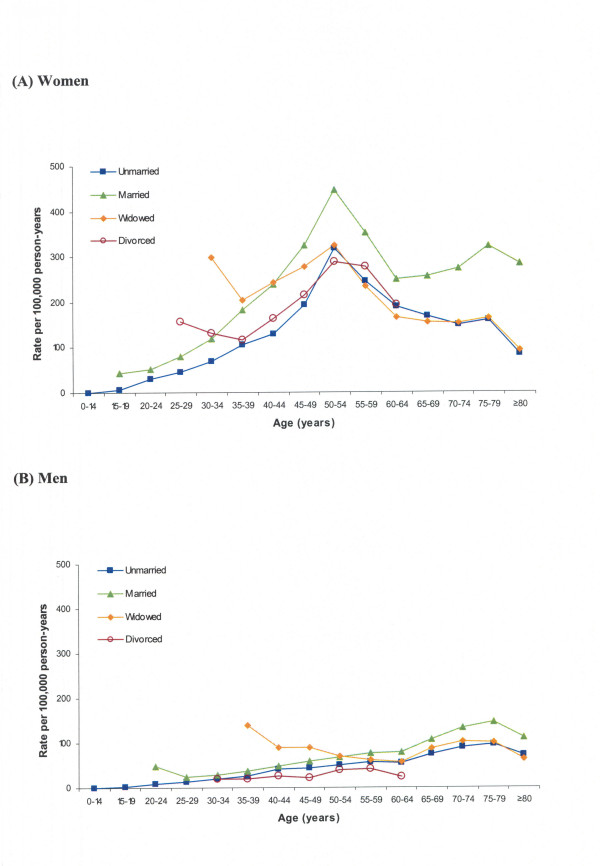
Age-specific rates of in-hospital cases of CTS according to marital status in (A) women and (B) men. (For divorced subjects, only younger age-groups–emerging after the introduction of the 1970 Italian divorce law–were analyzed.)